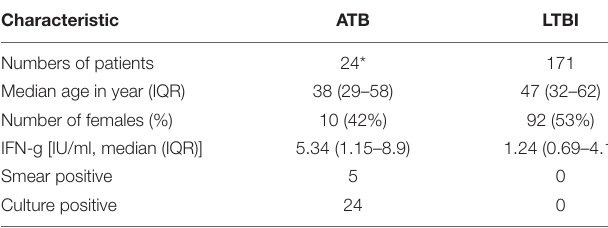
TABLE 1 | Patients’ characteristics.